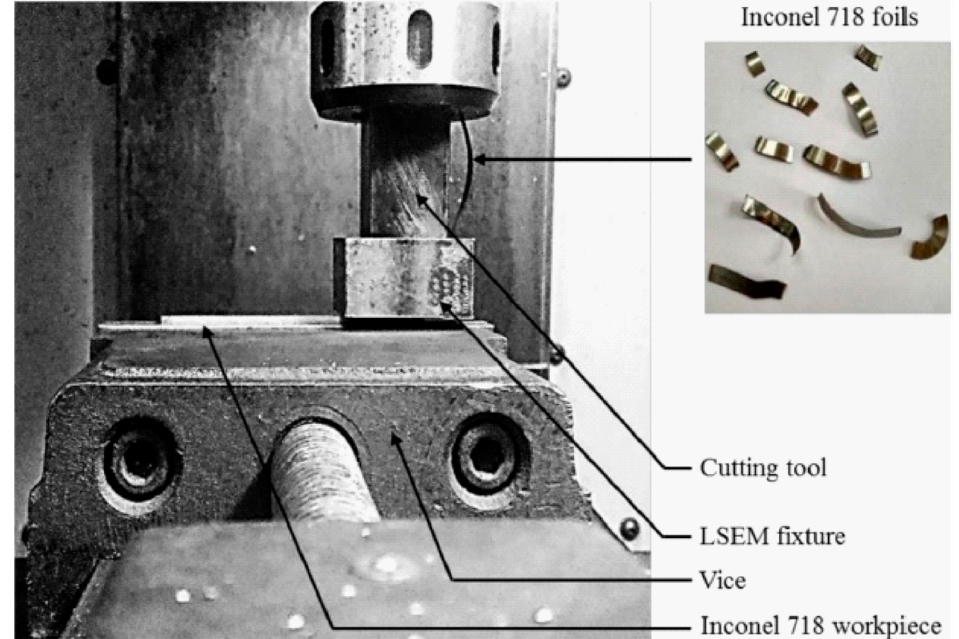
Figure 6. LSEM setup [22].